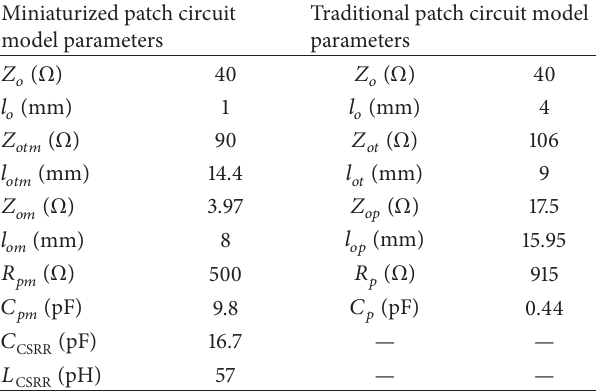
Figure 15: Comparison of circuit model and simulated reflection coefficient results of transmission line loaded with CSRR. Table 3: Circuit modeling parameters of traditional patch and miniaturized patch antenna.